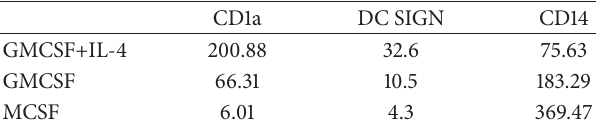
Table 2: Expression of CD1a, DC-SIGN, and CD14 cell surface molecules on monocyte-derived cells generated in the presence of the colony stimulating factors GM-CSF+IL-4, GM-CSF, or M- CSF. Peripheral blood-derived monocytes were differentiated in the presence of GM-CSF+IL-4, GM-CSF, or M-CSF in RPMI + 10% FCS for 3 days and the expression of the cell surface markers CD1a, DC-SIGN/CD209, and CD14 was monitored by flow cytometry using fluorescent labeled specific antibodies. The expression levels of CD1a, DC-SIGN, and CD14 are indicated as mean fluorescence intensity